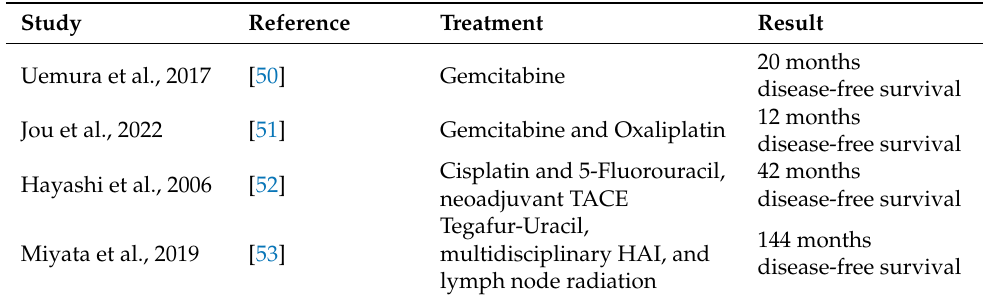
Table 2. Overview of published case reports on adjuvant systemic treatment for combined hepatocel- lular cholangiocarcinoma